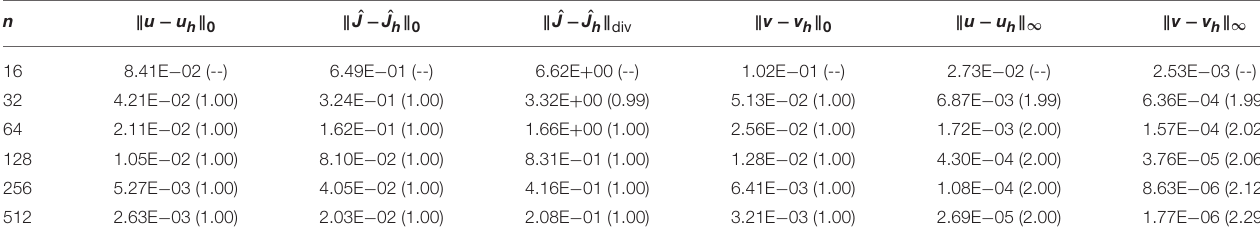
TABLE 4 | Convergence of the H(div) finite element method for the manufactured test problem, with convergence rates in